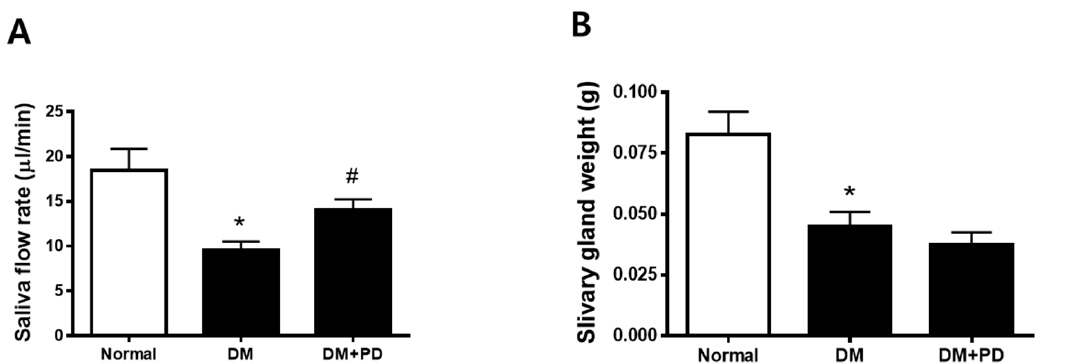
Figure 2. Effect of polydatin on salivation in type 2 diabetic db/db mouse. ( A ) Salivary flow rate. ( B ) Submandibular gland weight. Data are presented as the mean ± standard deviation ( n = 7). * p < 0.05 vs. Normal group; # p < 0.05 vs. DM group.